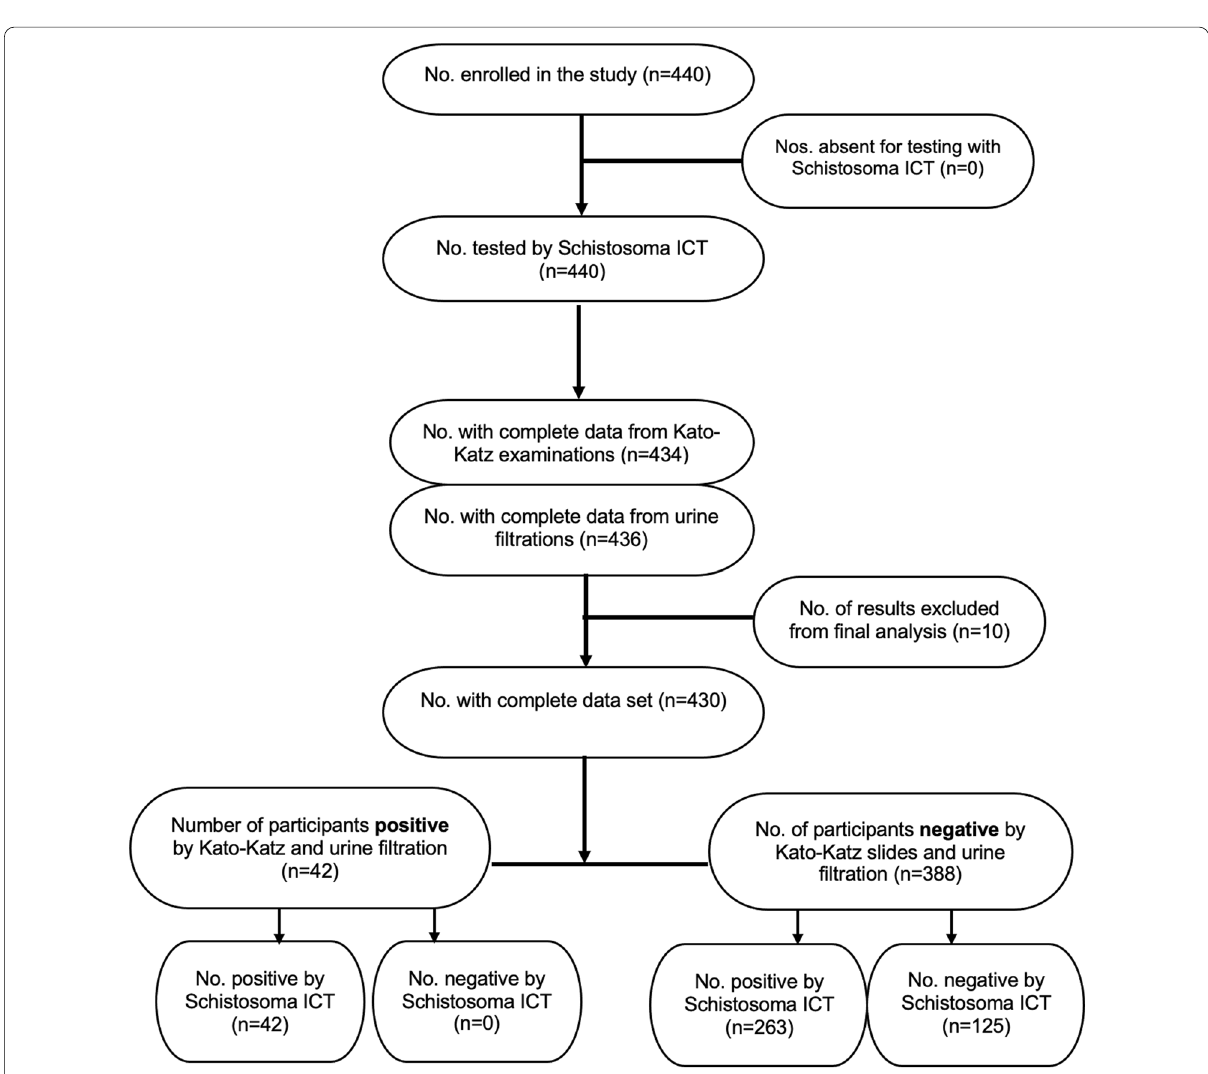
Fig. 1 Flow of participants and diagnostic performance of the Schistosoma ICT